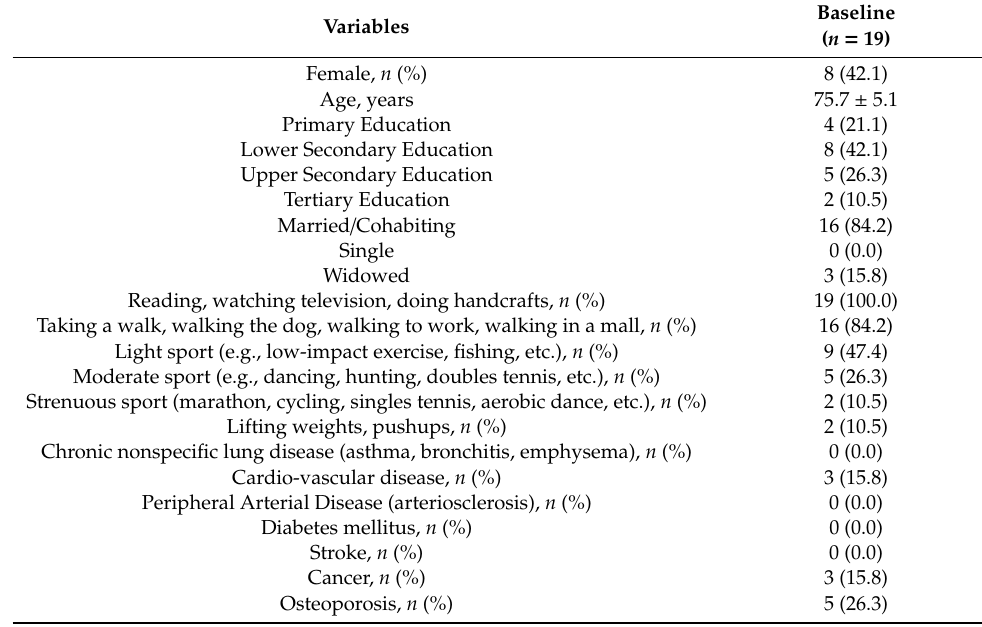
Table 1. Characteristics of the sample.